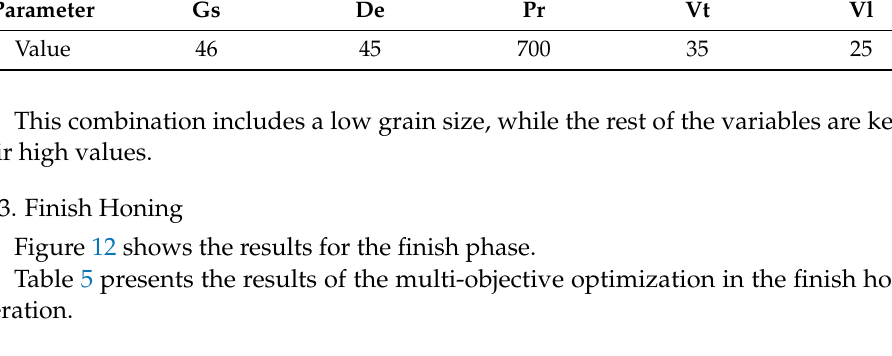
Table 5. Results of the multi-objective optimization in the finish honing